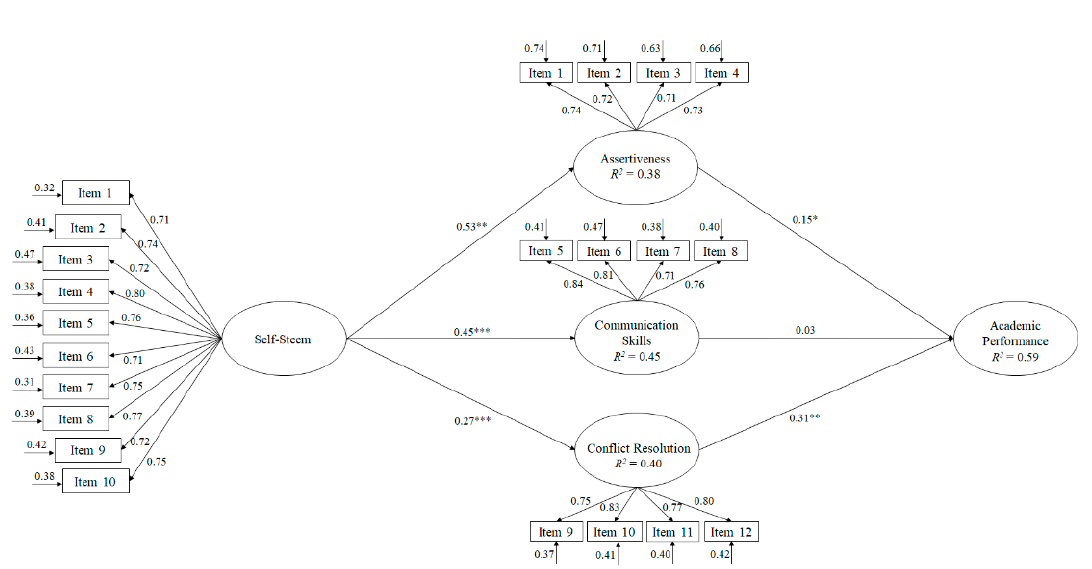
Figure 1. Hypothesized model, where all variables are related to one another. All parameters are standardized and are statistically significant. Note: *** p < 0.001; ** p < 0.01; * p < 0.05